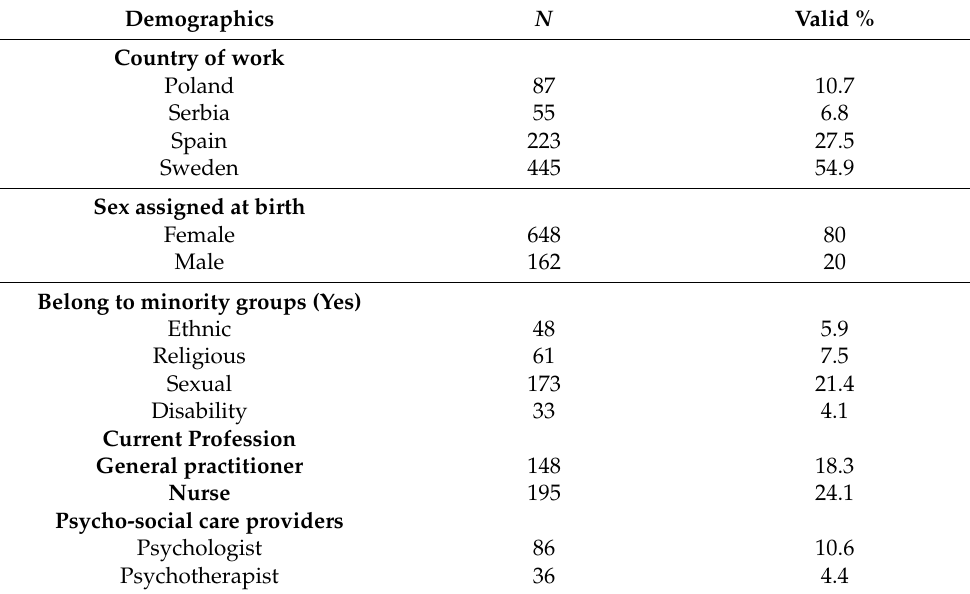
Table 1. Demographic variables ( N (%) for categorical variables, M(SD) for continuous